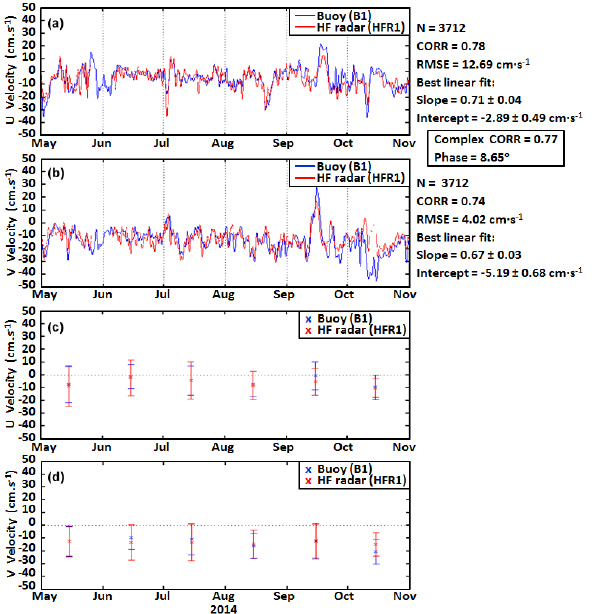
Figure 6. Low-pass filtered (cut-off period of 30h) hourly time se- ries of zonal (a) and meridional (b) components of total currents measured by the B1 buoy (blue line) and HF radar at the closest grid point HFR1 (red line), for a 6-month period May–October 2014. Mean zonal (c) and meridional (d) current velocities, averaged over individual months for both HF radar and B1 measurements, with 1 standard deviation (error bars represent the 95% confidence inter- val).